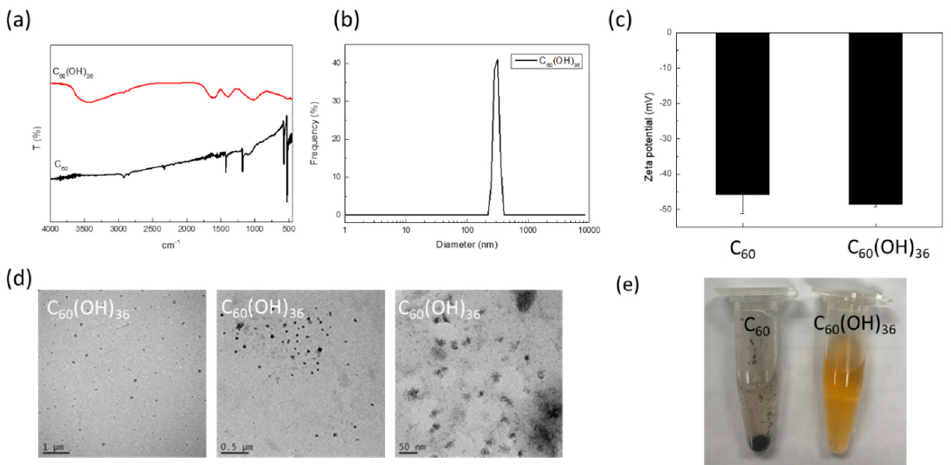
Figure 2. ( a ) FTIR, ( b ) DLS, ( c ) zeta-potential, and ( d ) TEM data; ( e ) images for fullerenol C 60 (OH) 36 or fullerene C 60 , respectively.